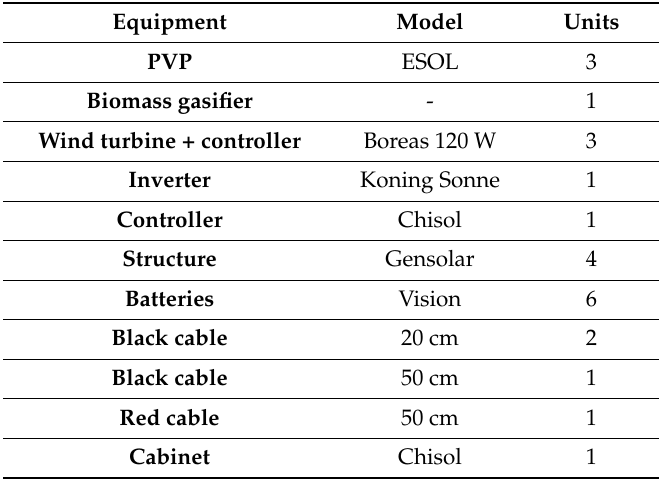
Figure 9. Simplified diagram of the resulting smart integrated renewable energy system (SIRES) to supply energy at a sector of Cabildo. Table 10. Equipment that makes up the smart integrated renewable energy system